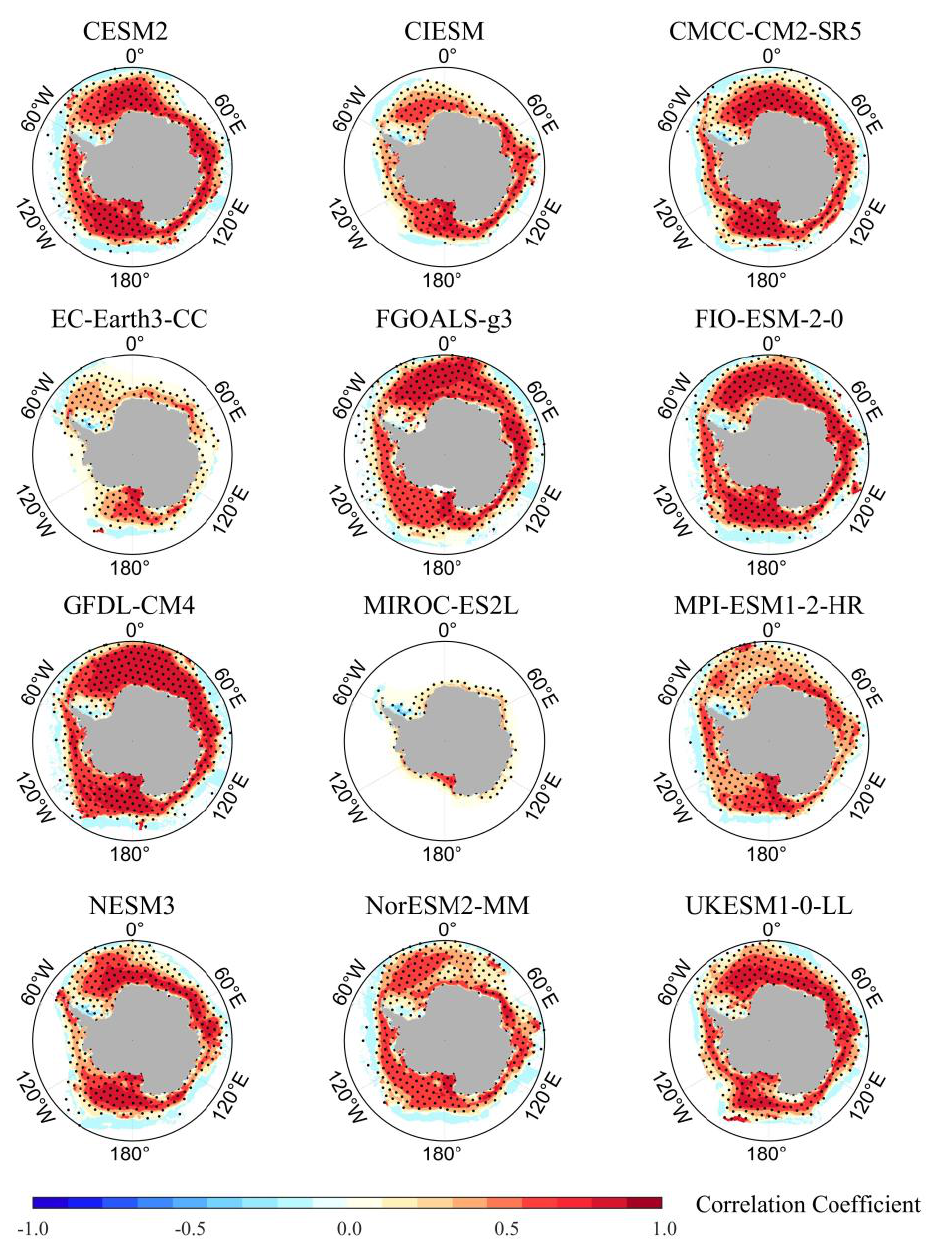
Figure 12. Distributions of correlation coefficients of SIC between the CMIP6 models and the observation. The black dots indicate the significance of the correlation coefficients at the 95% confidence level.